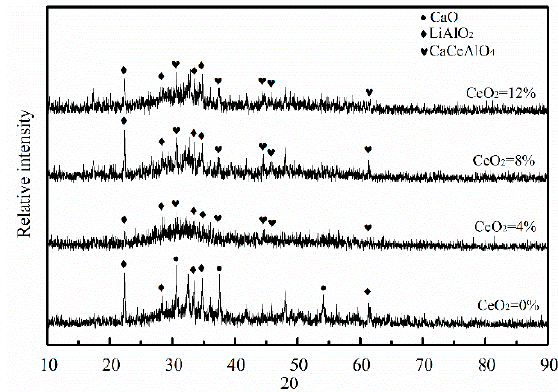
Figure 11. The crystal phases in the experimental mold fluxes quenched at break temperature.